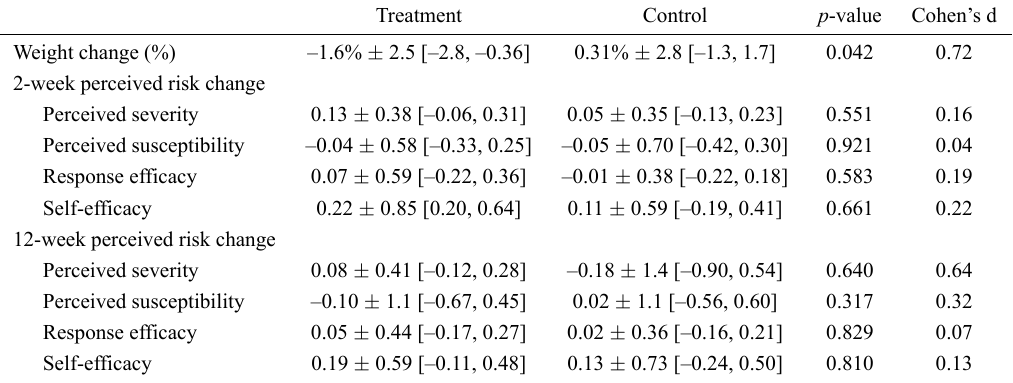
Table 2. Change in outcomes by arm (mean ± SD [95% Confidence